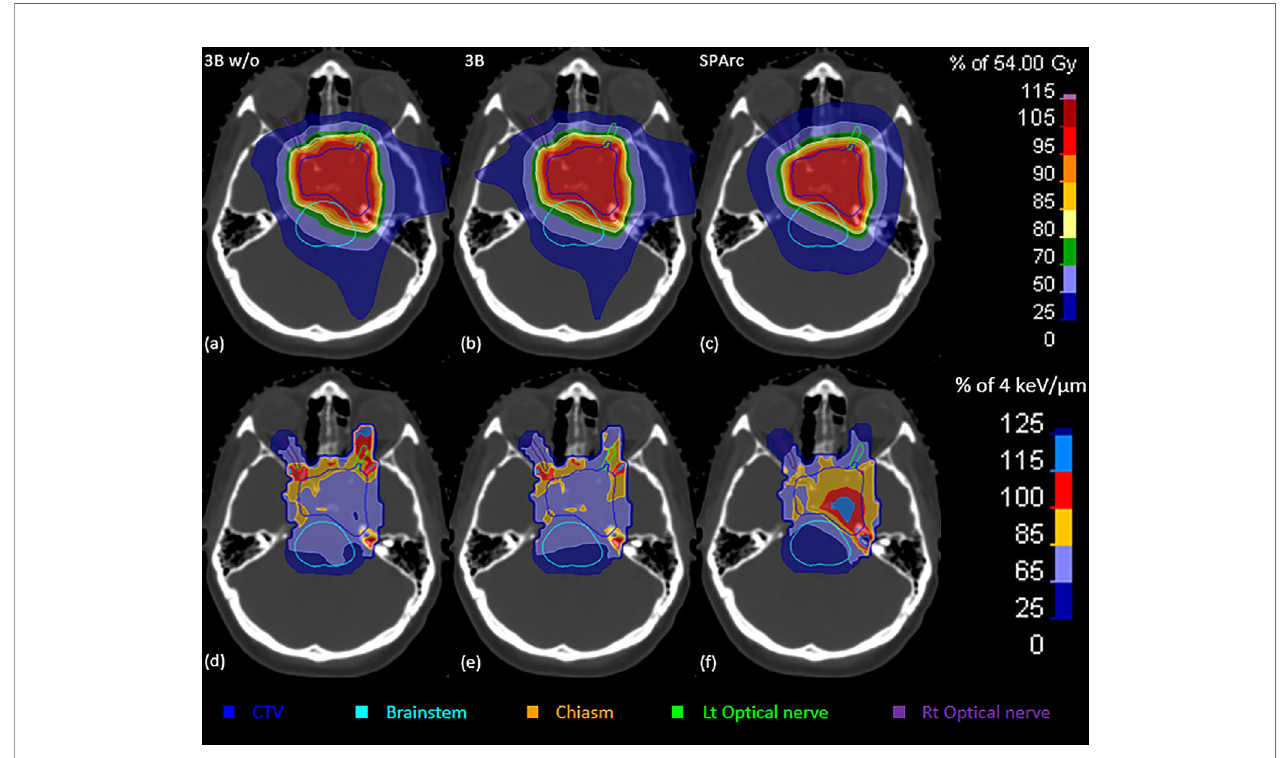
FIGURE 6 | The dose (upper row) and LET d (lower row) distributions of 3Bw/o (A, D) , 3B (B, E) , and SPArc (C, F) plans for the brain patient.